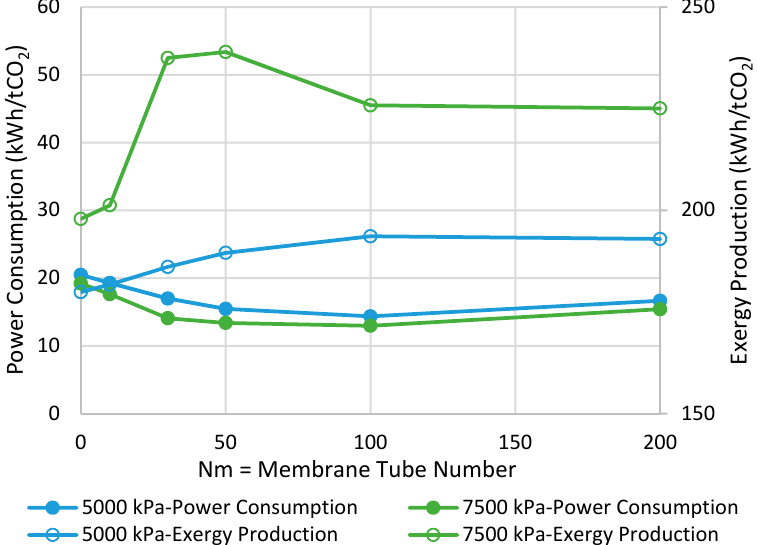
Figure 7. Comparison between isothermal CR- and MR-based processes with different membrane tube numbers using power consumption and exergy production (Nm = 0 corresponds to CR).